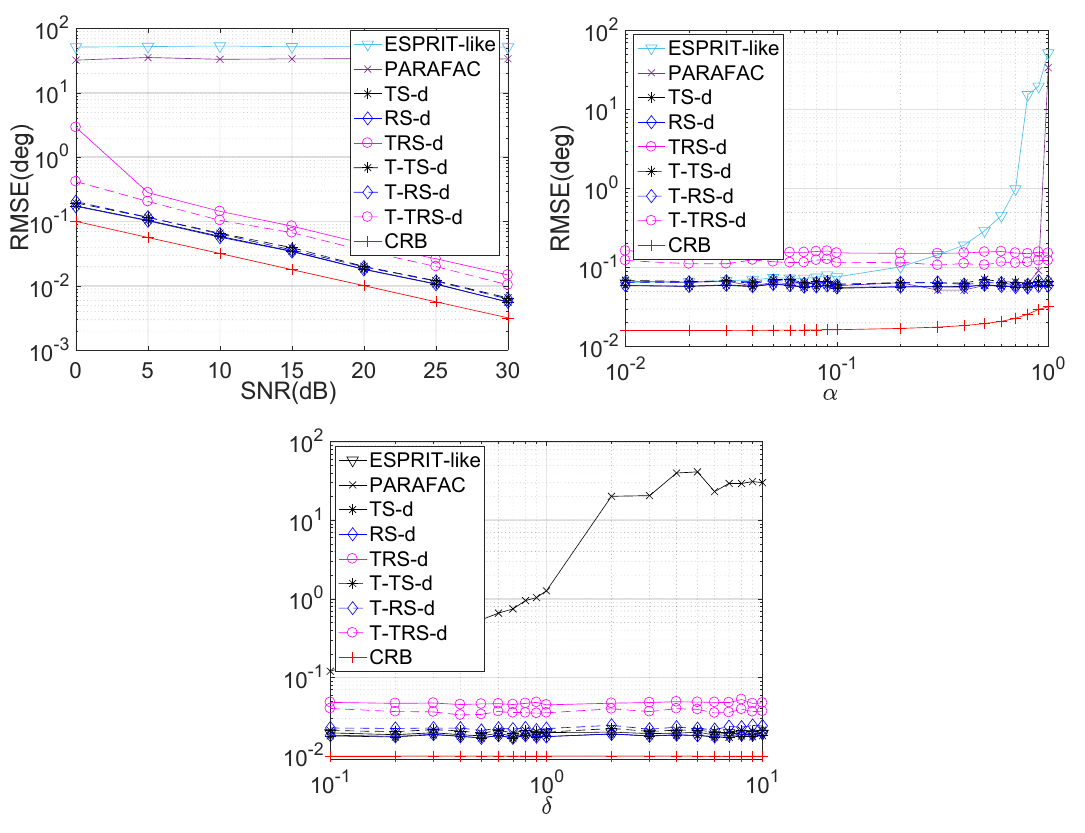
Figure 4. RMSE comparison in Case (II). ( upper left ) RMSE versus SNR comparison; ( upper right ) RMSE versus target correlation coefficient α ; ( lower left ) RMSE versus sensor position error factor δ . Example 4. RMSE comparisons versus snapshot L in case (I). Figure 5 presents the average RMSE on direction estimation and polarization estimation at different snapshot numbers L in Case (I), where the SNR is fixed at 10 dB and other conditions are the same as in Example 2. The observations in Figure 5 are similar to that in Figure 3. The proposed tensor-based approaches achieve better RMSE than the matrix-based approaches in polarization parameter estimation, but they may perform worse than the latter in direction parameter estimation.